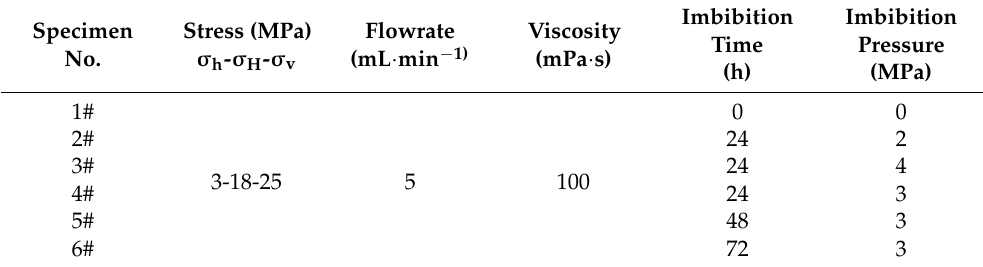
Table 2. Experimental scheme.